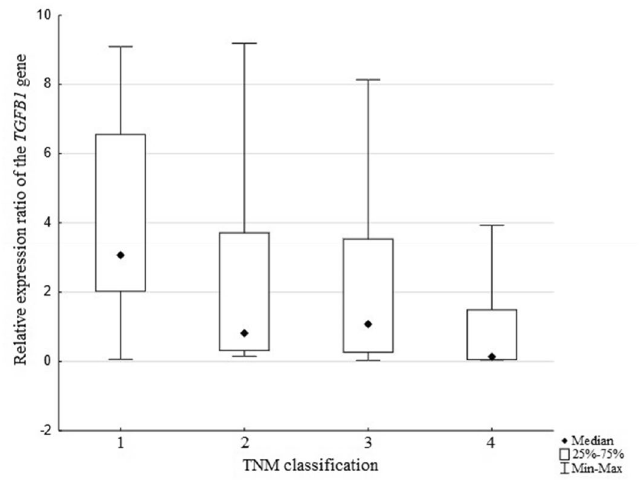
Figure 3. Relative expression levels of the TGFB1 gene and clinical stage according to the TNM classification.